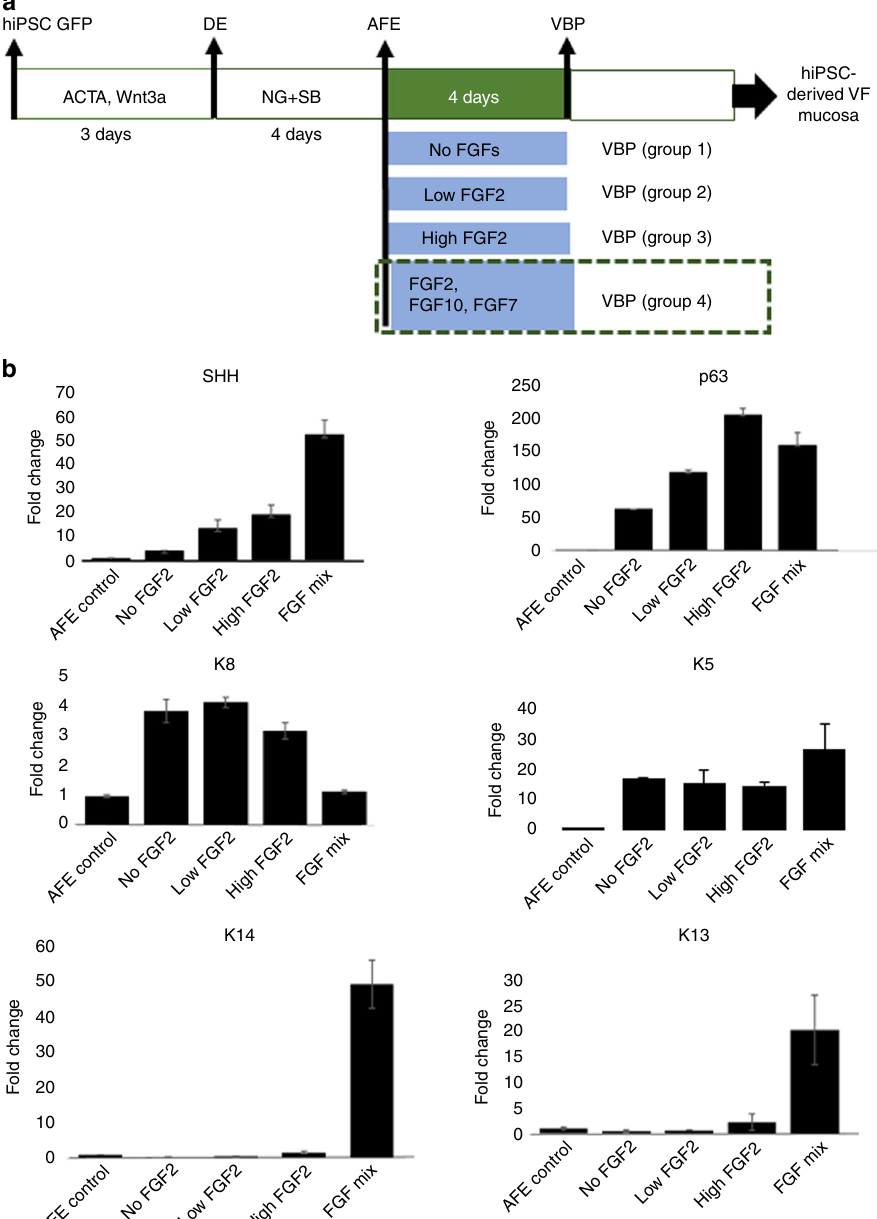
Fig. 3 Induction of strati fi cation in the AFE by modulating FGF signaling. a hiPSC were differentiated into the DE and AFE. AFE-derived cell cultures were then treated with various concentrations of fi broblasts growth factors (FGF2, FGF7, and FGF10) to derive VBP (groups 1 – 4). b Comparison in expression of SHH, Cytokeratin 8, and strati fi ed cell markers p63, Cytokeratin 5, 14, and 13 between experimental groups and AFE cells that were collected at day 8 of differentiation and received no treatment. Error bars represent ± standard error of the mean, n = 3 per group. We used one-way ANOVA to assess statistical signi fi cance for tested genes. All of the p- values for tested genes are below the threshold p- value < 0.05 indicating that expression levels of tested genes in FGFs treated groups signi fi cantly differed from the expression levels in AFE controls. ACTA Activin A, AFE anterior foregut endoderm, DE de fi nitive endoderm, hiPSC human induced pluripotent stem cells, NG noggin, SB SB-431542, VBP vocal fold basal progenitors. Source data provided as a Source Data fi